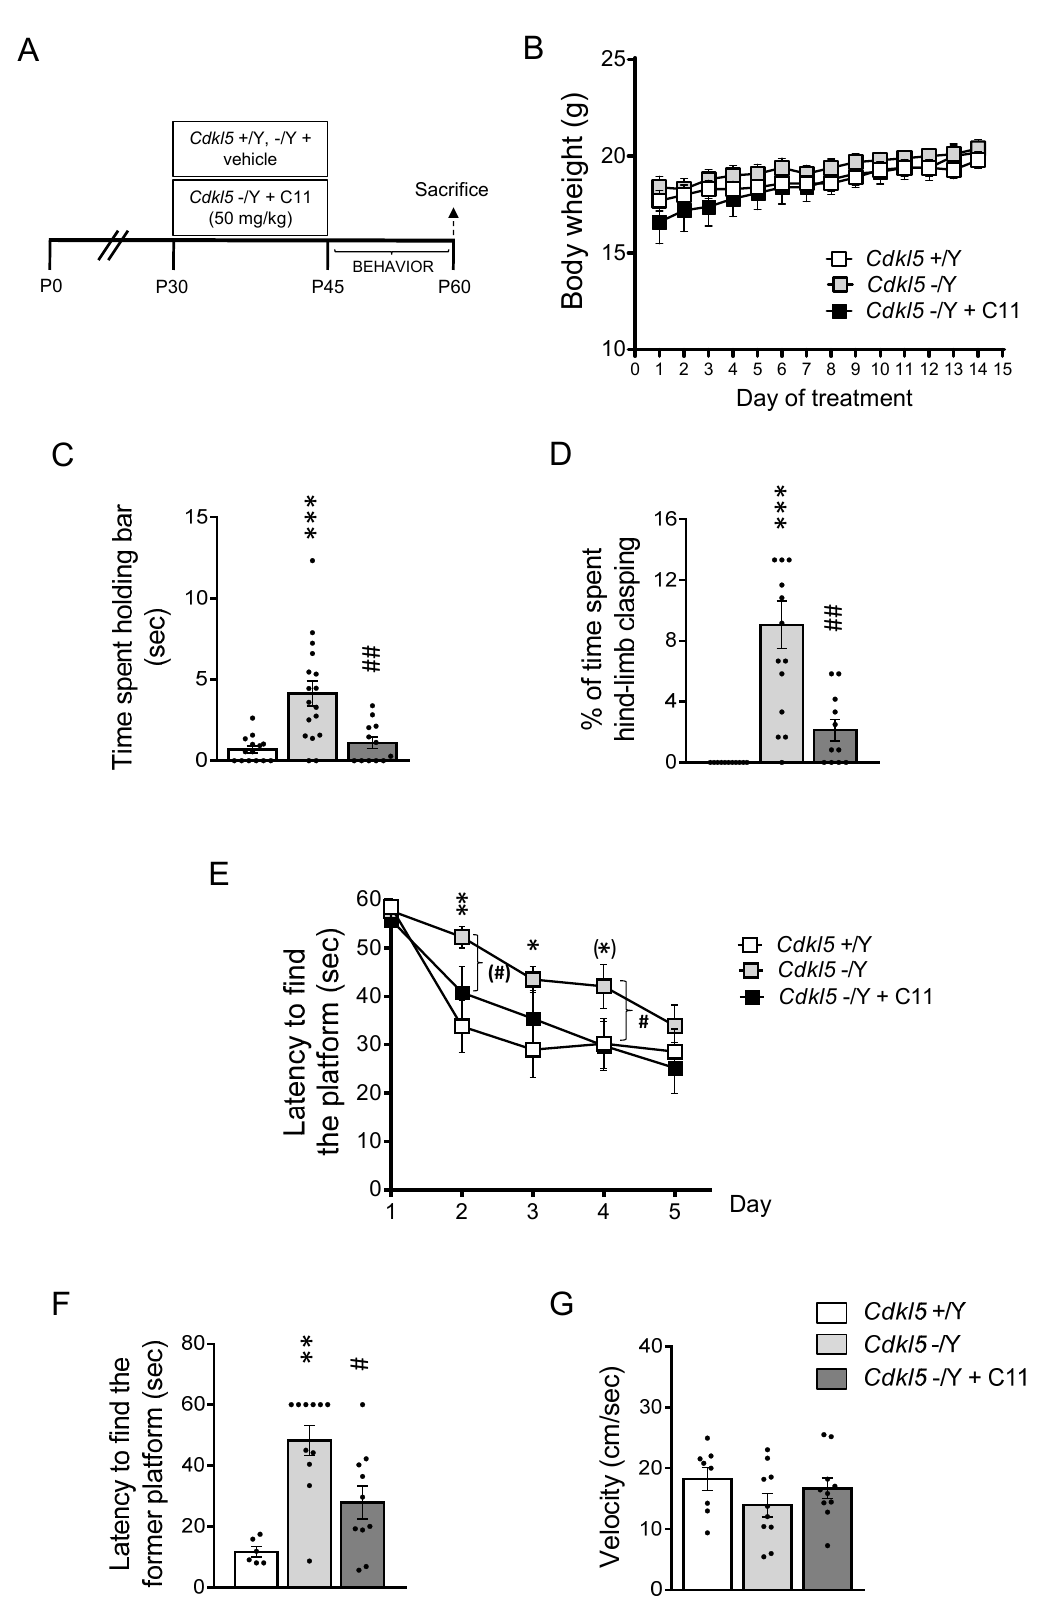
Figure 5. Effect of treatment with C11 on motor coordination and hippocampus-dependent learning and memory in Cdkl5 − /Y mice. ( A ) Experimental protocol. Starting from postnatal day 30 (P30), Cdkl5 +/Y mice were treated with vehicle and Cdkl5 − /Y male mice were treated with vehicle or C11 (50 mg/kg), administered via intraperitoneal injection every day for 15 days. Animals from different experimental groups were behaviorally tested. Animals were sacrificed 15 days after the